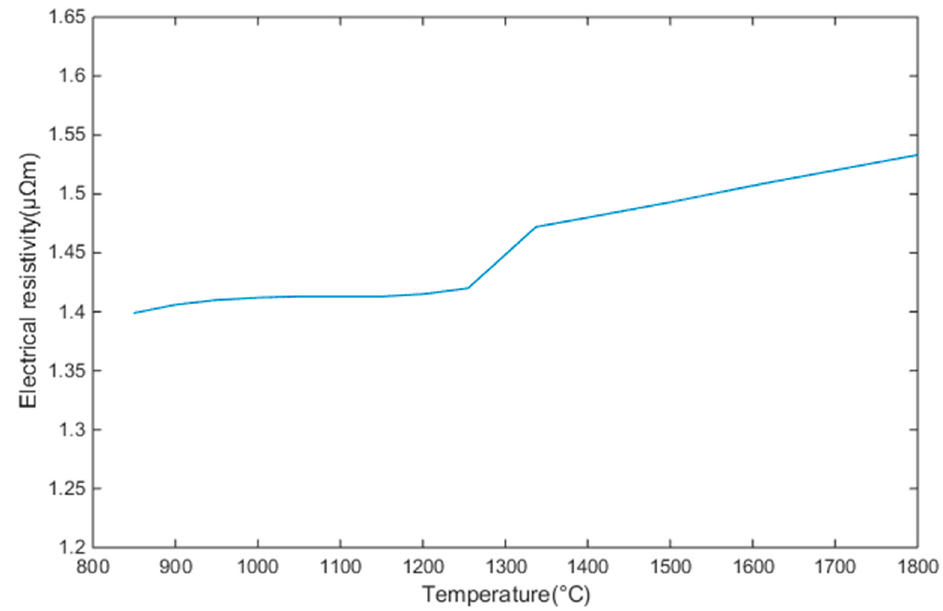
Figure 1. The relationship between electrical resistivity and temperature.